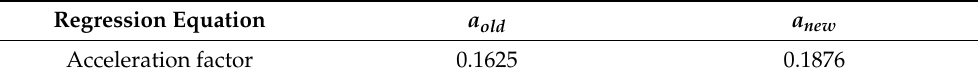
Table 3. Acceleration factor at 293.15 K obtained through different regression equations.